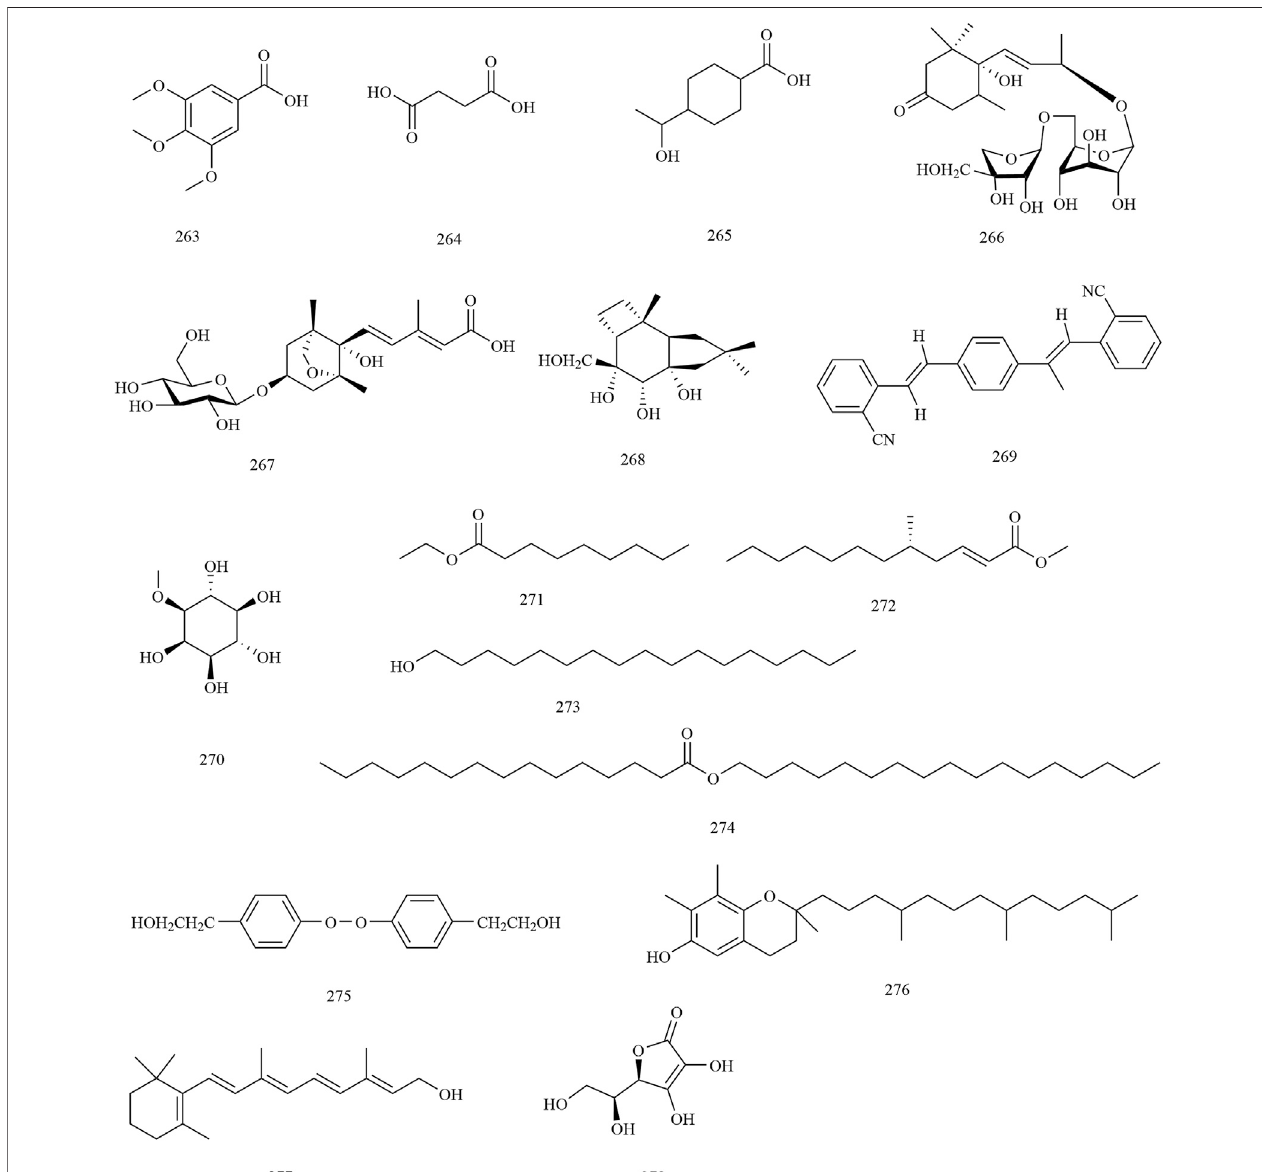
FIGURE 10 | Structures of other compounds in X. sorbifolium